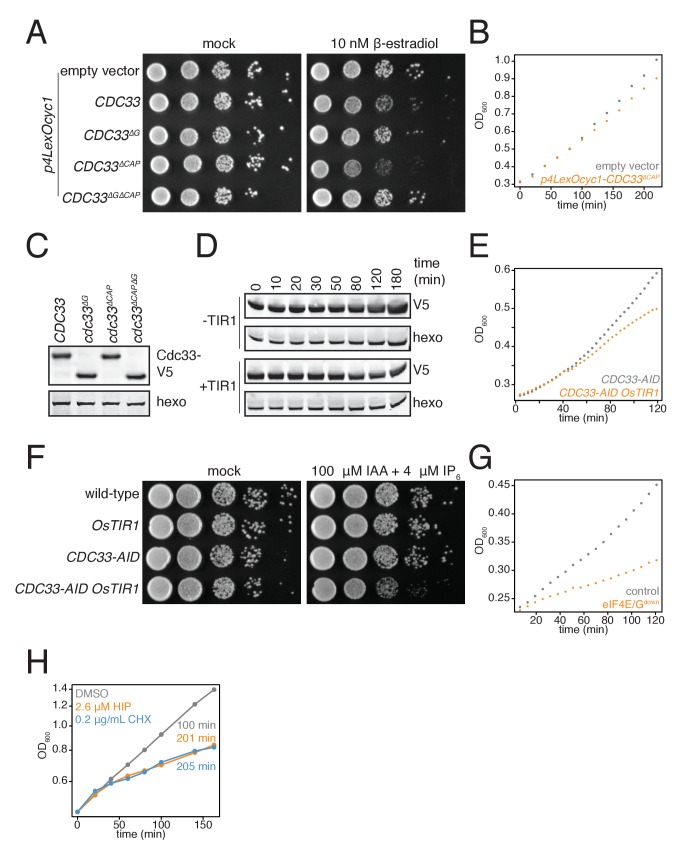
Biological replicates of experiments described in Figure 3B–G.(A) pGPD1-LexA-B112 cells harboring the following vectors: pRS425 (KWY7327 empty vector), pRS425-p4LexOCYC1-CDC33 (KWY7329), pRS425-p4LexOCYC1-CDC33∆G (KWY7330), pRS425-p4LexOCYC1-CDC33∆CAP (KWY7331) and pRS425-p4LexOCYC1-CDC33∆CAP∆G (KWY7332) were spotted on CSM-LEU and CSM-LEU + 10 nM β-estradiol media and incubated at 30°C for 36 hr. The first spot represents growth of approximately 6 × 104 cells and each subsequent spot is a 10 fold serial dilution. (B) pGDP1-LexA-B112 cells harboring pRS425 (KWY7327 empty vector, gray) or pRS425-p4LexOCYC1-CDC33∆CAP (KWY7331, orange) were grown to mid exponential phase, treated with 10 nM β-estradiol and growth was monitored by absorbance at 600 nm. (C) pGDP1-LexA-B112 cells harboring the following vectors: pRS425-p4LexOCYC1-CDC33-3V5 (KWY7328), pRS425-p4LexOCYC1-CDC33∆G-3V5 (KWY7338), pRS425-p4LexOCYC1-CDC33∆CAP-3V5 (KWY7339) and pRS425-p4LexOCYC1-CDC33∆CAP∆G-3V5 (KWY7340) were grown to mid exponential phase in CSM-LEU media, treated with 10 nM β-estradiol for 20 min and then harvested for western blot analysis. Hexokinase was used as a loading control. (D) CDC33-IAA7-3V5 cells expressing OsTIR1 (KWY7326) or not expressing OsTIR1 (KWY7325) were grown to mid exponential phase in CSM pH5.5 media, treated with 100 μM 3-indoleacetic acid and 4 μM IP6 and then harvested at the indicated timepoints for western blot analysis. Hexokinase was used as a loading control. (E) CDC33-IAA7-3V5 cells expressing OsTIR1 (KWY7326, orange) or not expressing OsTIR1 (KWY7325, gray) were grown to mid exponential phase in CSM pH5.5 media, treated with 100 μM 3-indoleacetic acid and 4 μM IP6 and growth by absorbance at 600 nm was monitored. (F) Wild-type (KWY165), pGPD1-OsTIR1 (KWY7333), CDC33-IAA7-3V5 (KWY7325) and pGPD1-OsTIR1 CDC33-IAA7-3V5 (KWY7326) cells were spotted on YePD pH5.5 and YePD pH5.5+100 μM 3-indoleacetic acid and 4 μM IP6 media and incubated at 30°C for 36 hr. The first spot represents growth of approximately 6 × 104 cells and each subsequent spot is a 10 fold serial dilution. (G) pGPD1-LexA-B112 CDC33-IAA7-3V5 pRS425 (KWY7336 ‘control’, gray) and pGPD1-LexA-B112 pGPD1-OsTIR1 CDC33-IAA7-3V5 pRS425-p4LexOCYC1-CDC33∆CAP (KWY7334 ‘eIF4E/Gdown’, orange) cells were grown in CSM –LEU pH5.5 to mid exponential phase, treated with 10 nM β-estradiol, 100 μM 3-indoleacetic acid and 4 μM IP6 and growth by absorbance at 600 nm was monitored. (H) Wild-type cells (KWY165) were treated with 0.1% DMSO (gray) or 2.6 μM hippuristanol (orange) or 0.2 μg/mL cycloheximide (blue) and growth was monitored by absorbance at 600 nm. The y-axis is in log scale. The values are the computed doubling times.